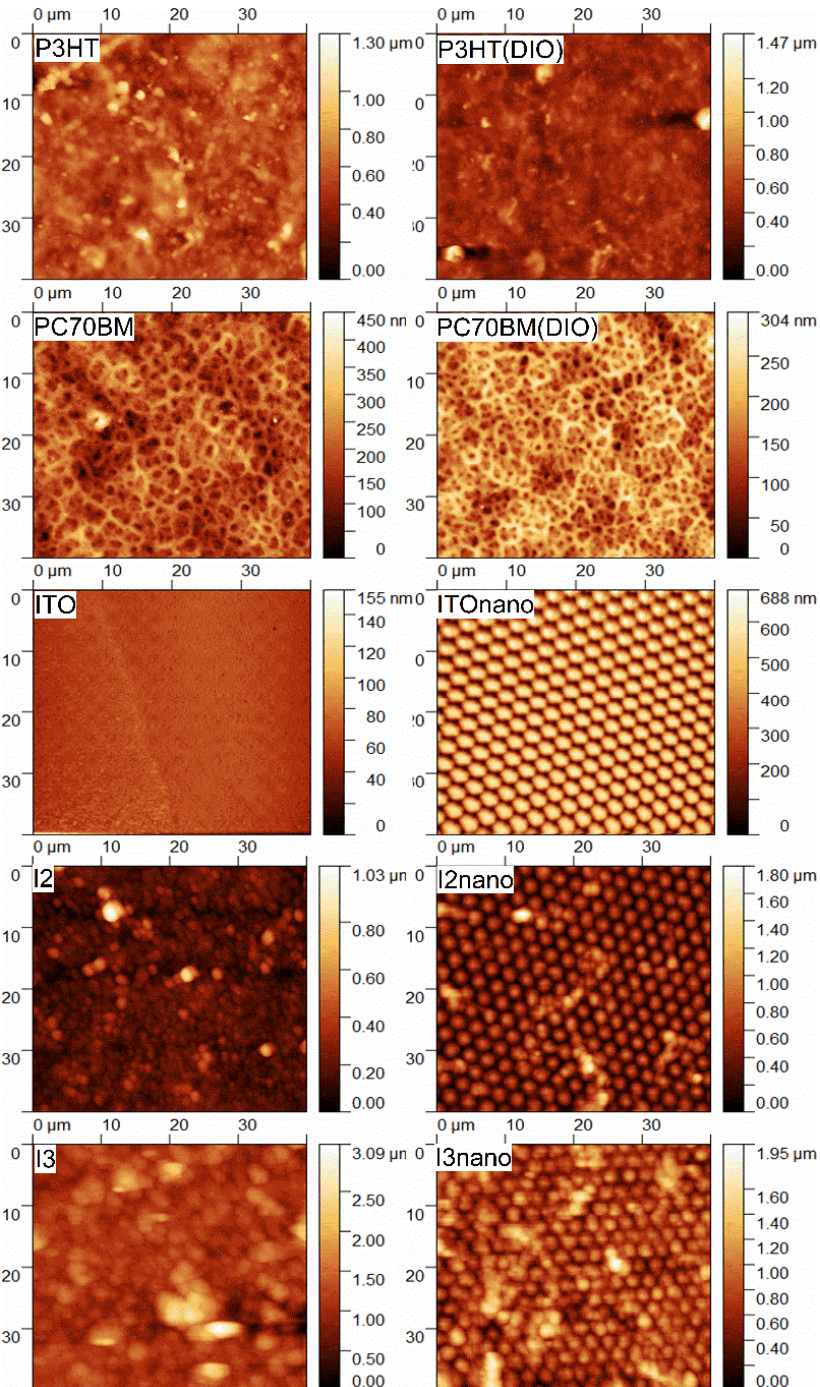
Figure 3. AFM images of P3HT and PC70BM as reference films deposited by MAPLE, flat ITO, and patterned ITOnano substrates and MAPLE blend layers: I2, I2nano deposited from P3HT:PC70BM (1:0.7) and I3, I3nano deposited from P3HT:PC70BM (1:1). This result is in conformity with the values obtained for the root mean square rough- ness (RMS) and roughness average (Ra) parameters, which decrease from 112 nm to 105 nm and from 84 nm to 70 nm, respectively, as can be seen in Table 4. The additive also